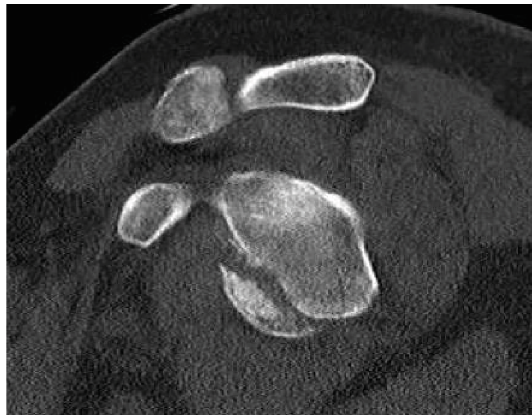
Figure 1: Sagittal CT image demonstrating large anteroinferior glenoid rim fracture involving approximately 25% of the glenoid width.